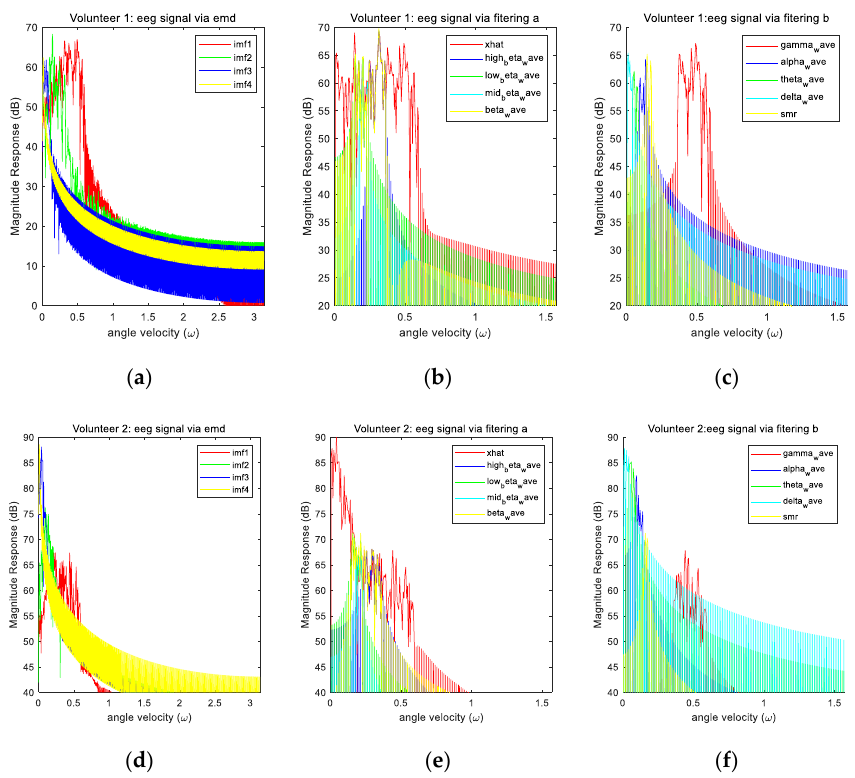
Figure 3. ( a ) The magnitude responses of the intrinsic mode functions of the electroencephalograms when the first volunteer performs various activities. ( b ) and ( c ) The magnitude responses of the filtered electroencephalograms when the first volunteer performs various activities. ( d ) The magnitude responses of the intrinsic mode functions of the electroencephalograms when the second volunteer performs various activities. ( e ) and ( f ) The magnitude responses of the filtered electroencephalograms when the second volunteer performs various activities.